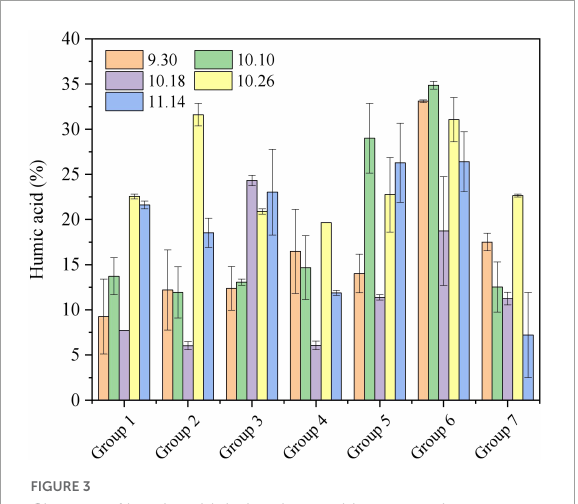
FIGURE3 Changes of humic acid during the aerobic composting progress. The brief description of the symbols in the figures were similar with Figure 1